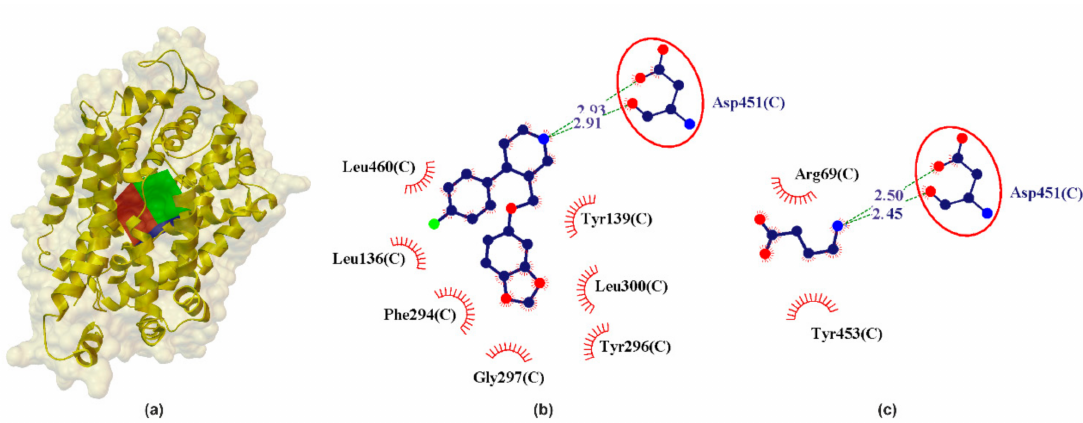
Figure 5. X-ray structure of the hGAT1 homology model ( a ) with the grid box showing the ligand-binding site (Swiss-Prot ID: P30531) and calculated data ( b ) for binding pocket in PRX–hGAT1 and ( c ) GABA–hGAT1 complex. The red circles and ellipses identify equivalent residues (in 3D superposition of